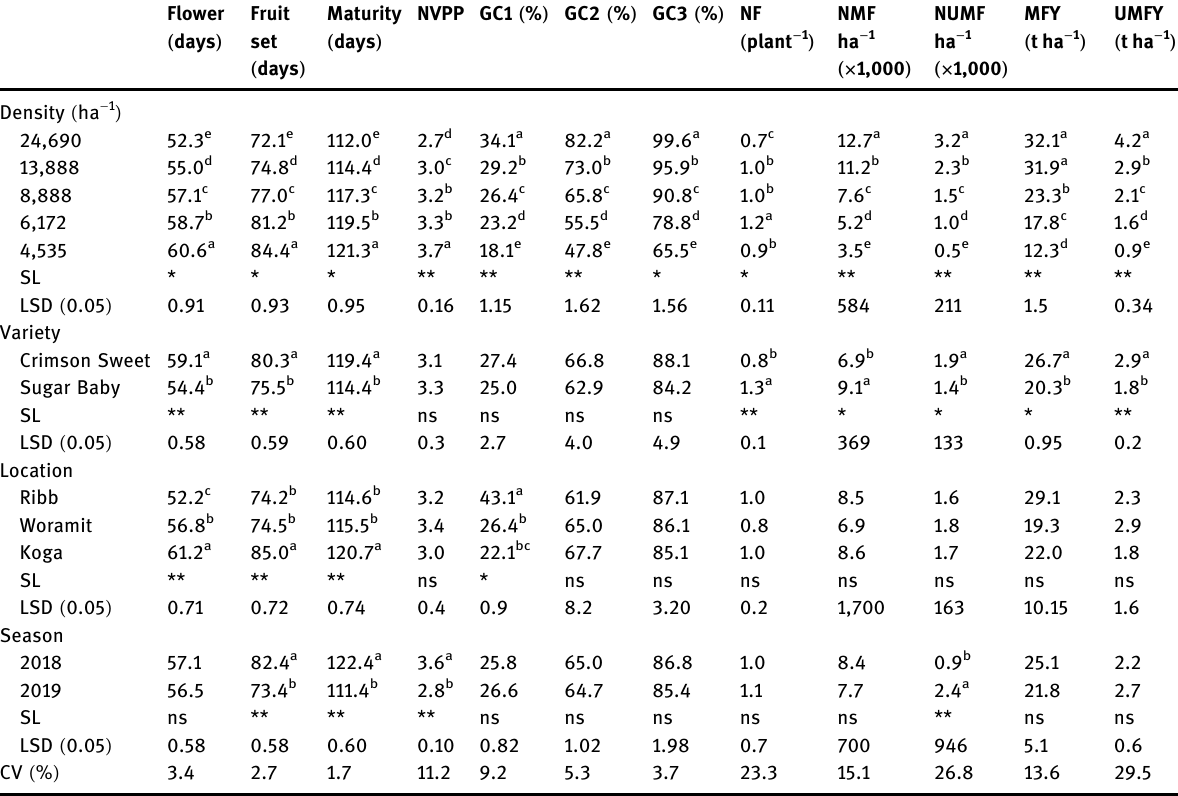
Table 3: Main e ff ect of density, location, and season on the growth yield component and yield of watermelon Flower ( days )